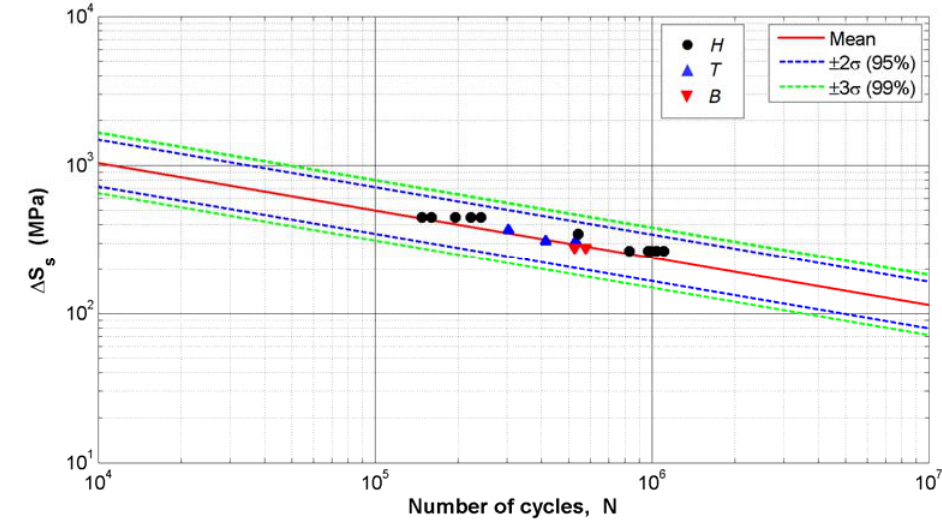
Figure 10 : 2007 ASME Div.2 master S-N curve and experimental